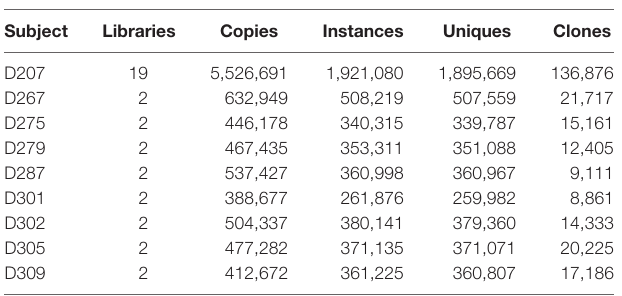
tABlE 4 | Sequencing data